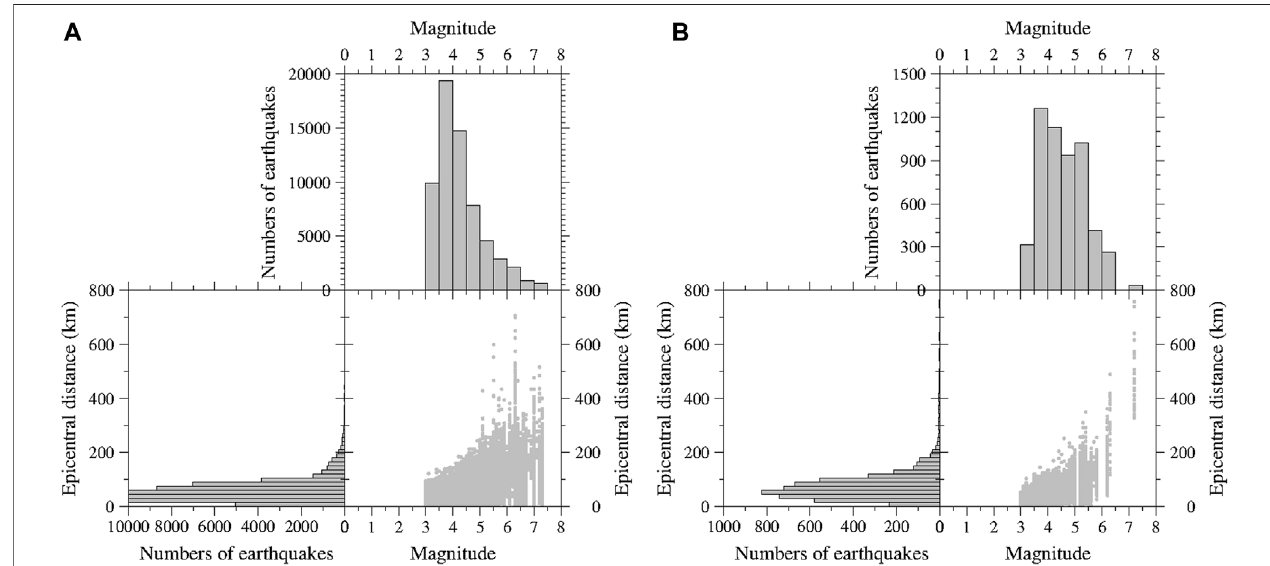
FIGURE 3 | (A) Magnitude and epicentral distance distribution of the training set; (B) Magnitude and epicentral distance distribution of the testing set.